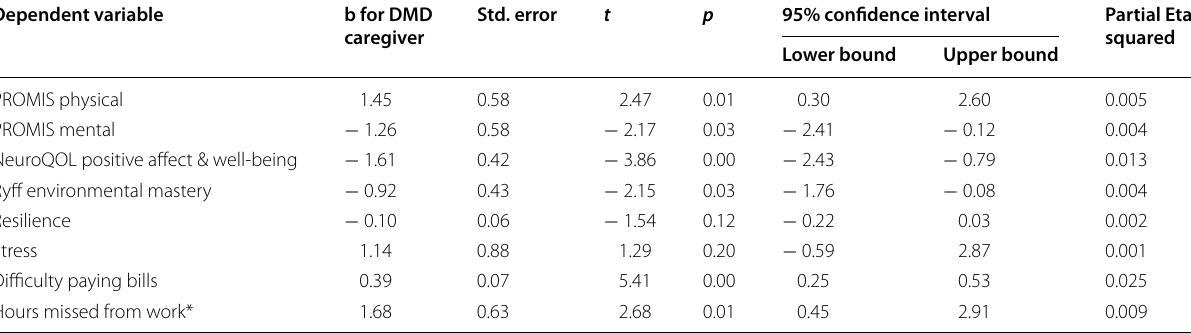
Table 4. Group effects from general linear models adjusted for propensity